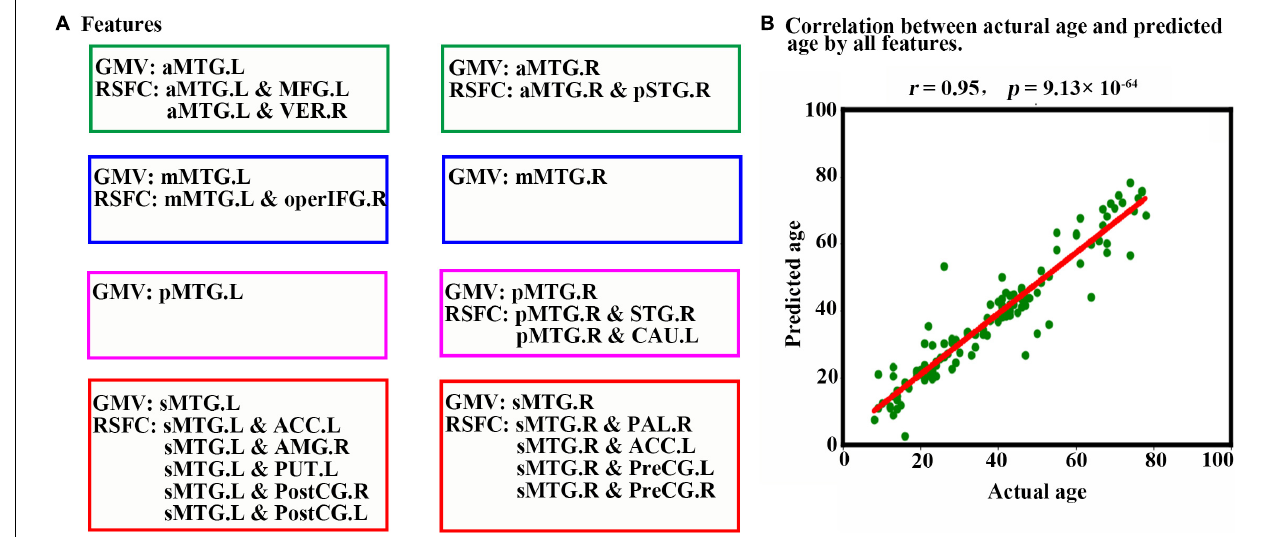
FIGURE 4 | Prediction results based on features from MTG sub-regions using LSTM. (A) Features are used to predict an individual’s age in the LSTM network. The scatter plot depicts actual age versus predicted age by all features. (B) Pearson correlation analyses between the actual and predicted ages are performed to evaluate the prediction accuracy. Abbreviations of brain regions are listed in Table 1